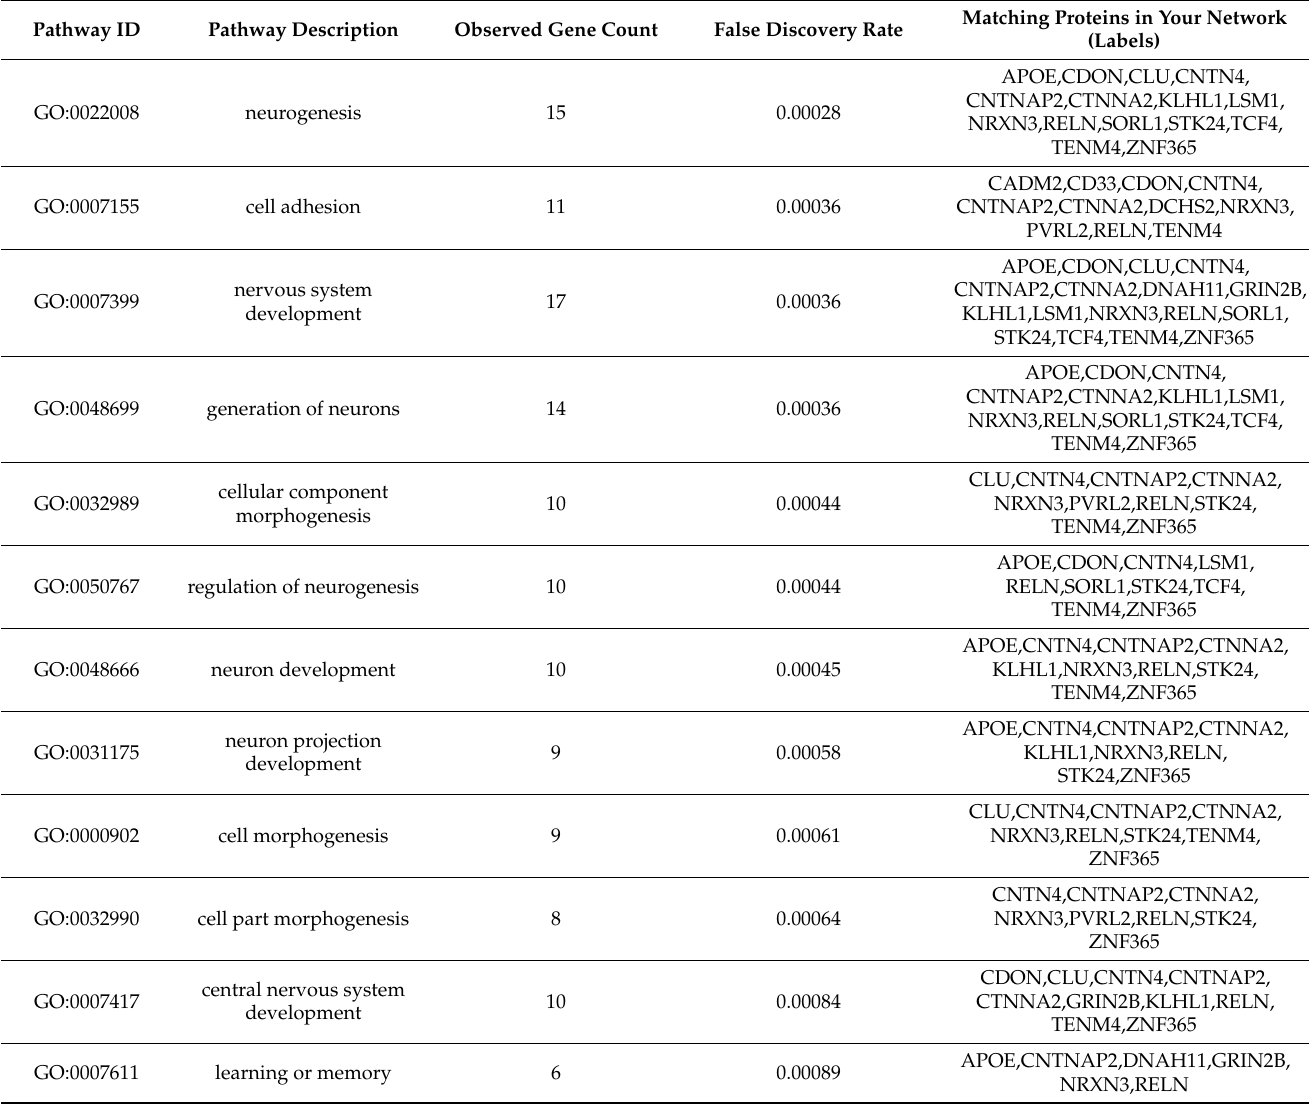
Table 6. Significantly enriched pathways of studied